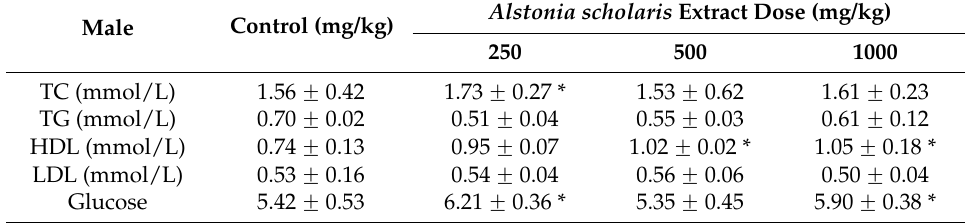
Table 8. Effect of 28 days of oral administration of the methanolic extract of the bark of Alstonia scholaris on serum lipid profiles and plasma glucose levels in male rats. Results were expressed as the mean ˘ S.E.M. of 5 rats.